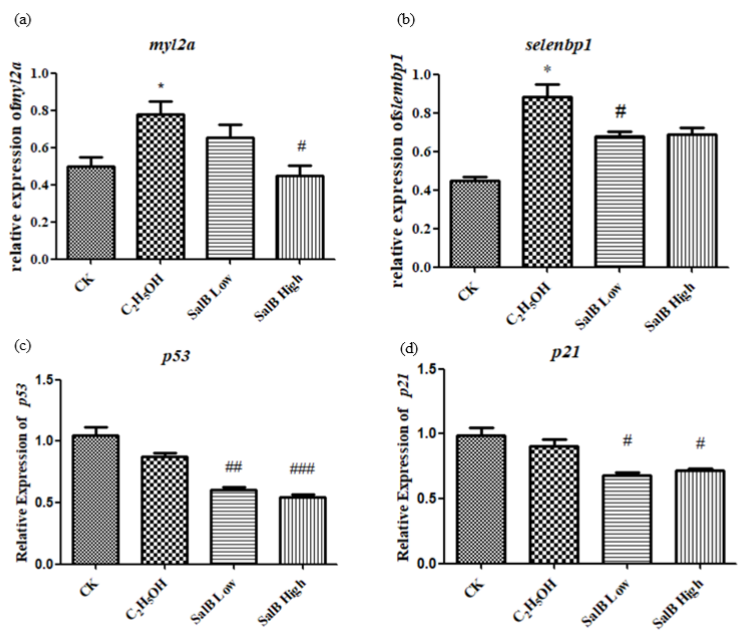
Figure 10. The expression of myl2a ( a ), selenbp1 ( b ), p53 ( c ) and p21 ( d ) after Sal B added in the group of ethanol acute toxicity treatment. The statistical results shown represent the means ( n = 3); vs. the control group ( n = 3) * p < 0.05, ** p < 0.01, *** p < 0.001 vs. the ethanol-treated group ( n = 3) # p < 0.05, ## p < 0.01, ### p < 0.001.